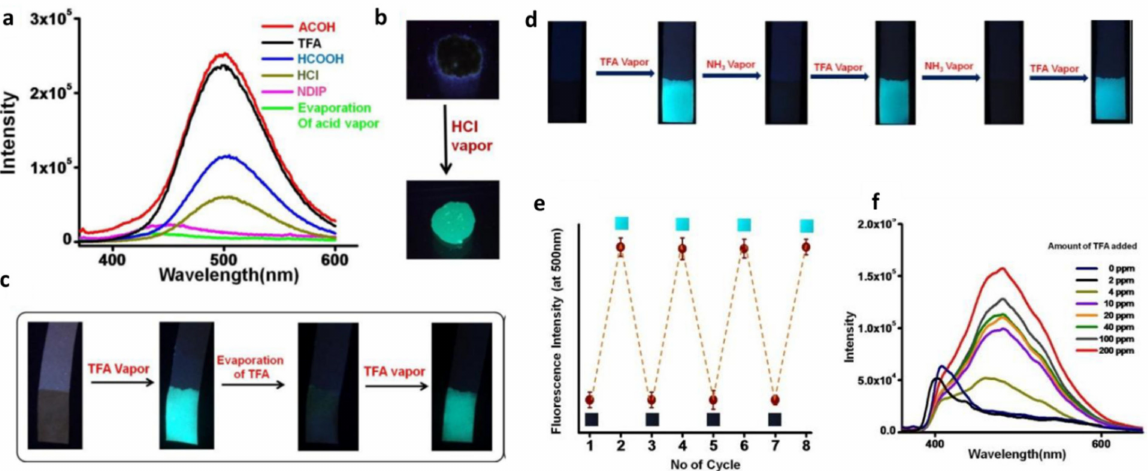
Figure 12. ( a ) Fluorescence spectra of NDIP xerogels upon exposure to different volatile acid vapors. ( b ) Fluorescence "turn on" of NDIP xerogels upon exposure to HCl vapor. ( c ) Fluorescence on/off behavior by exposure and evaporation of acid vapor using a paper strip impregnated with NDIP. ( d ) Fluorescence on/off switching upon exposure to TFA and ammonia vapors of the paper strip device impregnated with NDIP. ( e ) Fluorescence on/off cycle of NDIP in the presence of acid and base vapors. ( f ) Fluorescence spectra of NDIP in milli-Q water in different amounts (ppm) of trifluoroacetic acid (TFA). From [32]. Copyright Wiley-VCH GmbH. Reproduced with permission.